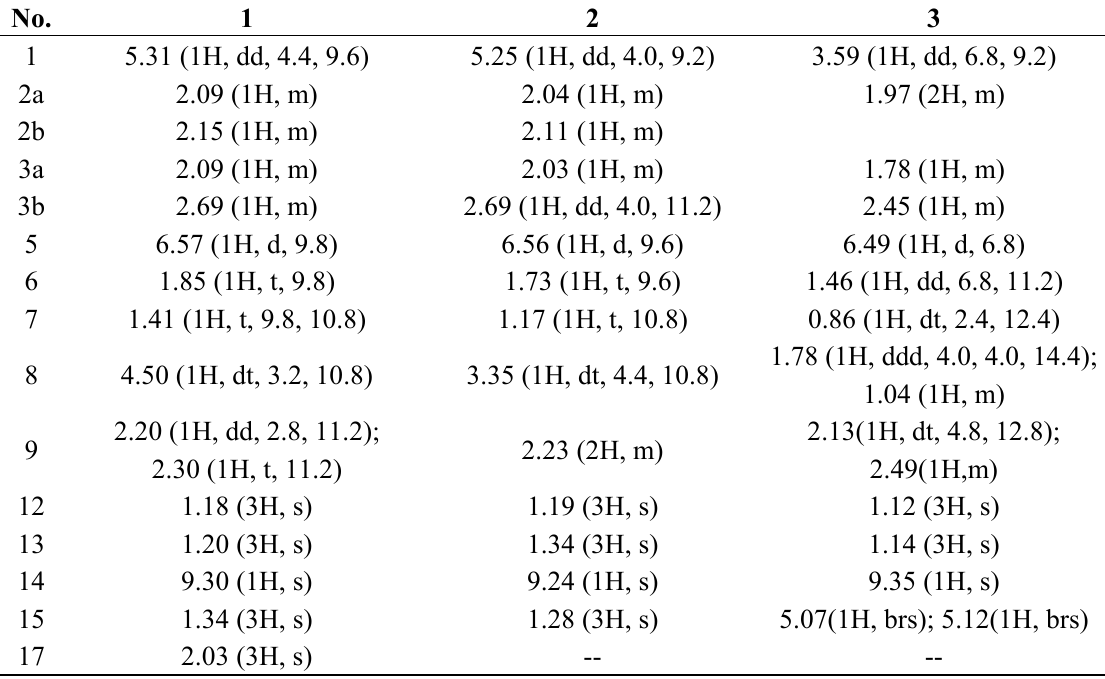
OD ( δ in ppm, recorded at 400 MHz). 3